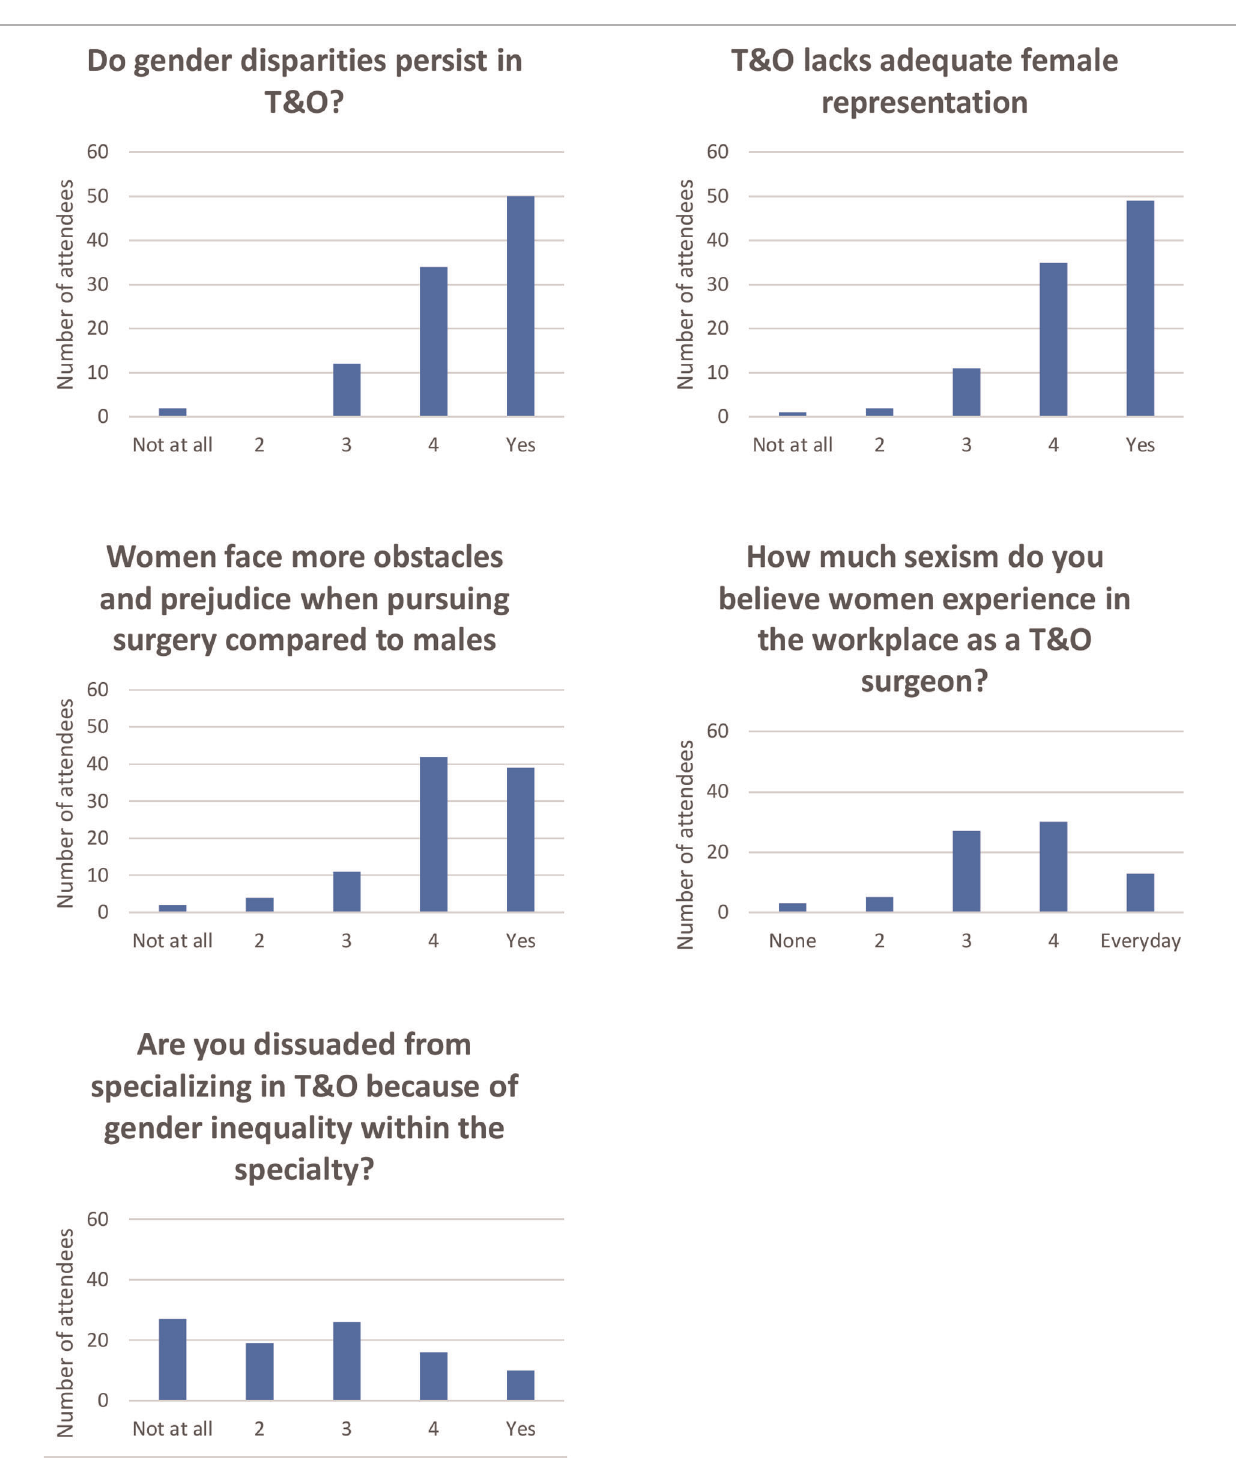
FIGURE 1 | Pre-event perceptions of